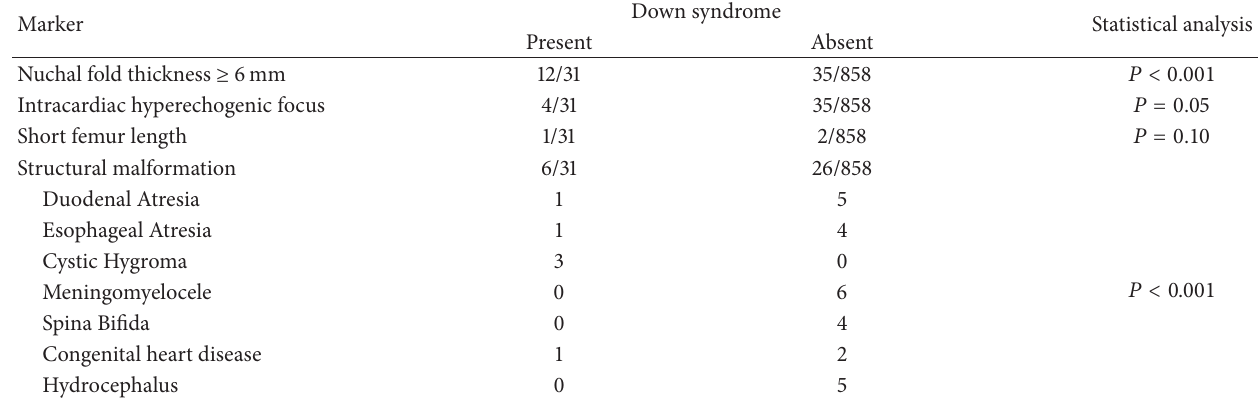
Table 3: Correlation between ultrasound markers and Down syndrome.